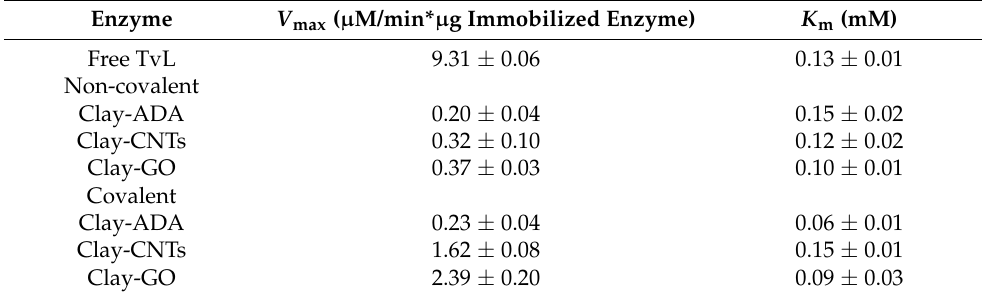
Table 3. Determination of the apparent kinetic parameters of free and immobilized TvL.